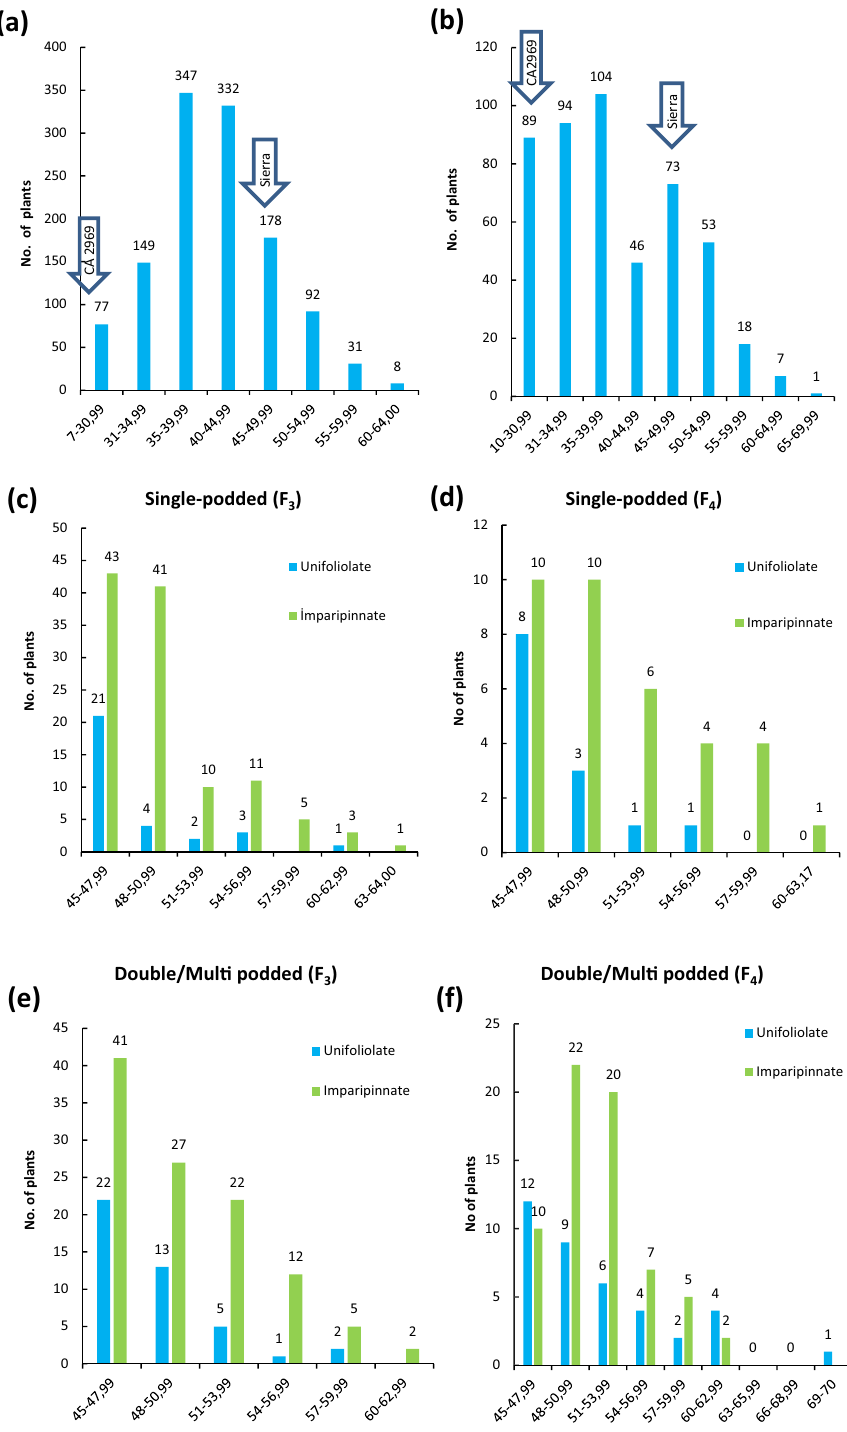
Figure 4. Distribution of 100-seed weight in F 3 ( a ) and F 4 ( b ). Distribution of 100-seed weight of genotypes with single-poddded and 100-seed weight ≥ 45 g according to leaf shape in F 3 ( c ) and F 4 ( d ). Distribution of 100-seed weight of genotypes with double/multi-poddded and 100-seed weight ≥ 45 g according to leaf shape in F 3 ( e ) and F 4 ( f ). A line in F 4 (multi-podded per axil, imparipinnate-leafed) derived from intraspecific crosses between Sierra (single-podded and unifoliolate-leafed) and CA 2969 (double-podded and imparipinnate-leafed) ( g ). Seeds of a superior line (multi-podded, unifoliolate-leafed and 69.6 g per 100-seeds, left side) in F 4 and its large-seeded parent Sierra (single-podded, unifoliolate-leafed and 46.9 g per 100-seeds, right side) ( h